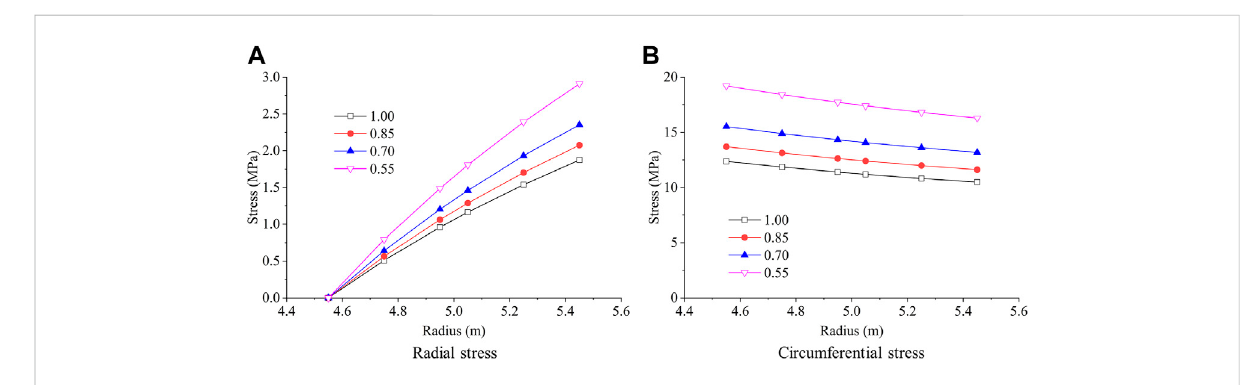
FIGURE 14 In fl uence of degree of anisotropy k a under state